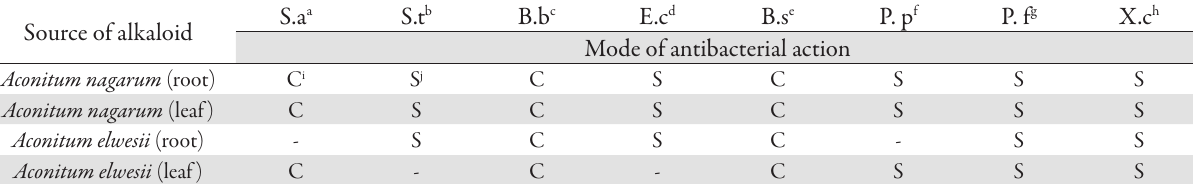
Tab. 4. Mode of antibacterial action of Aconitum alkaloid extracts